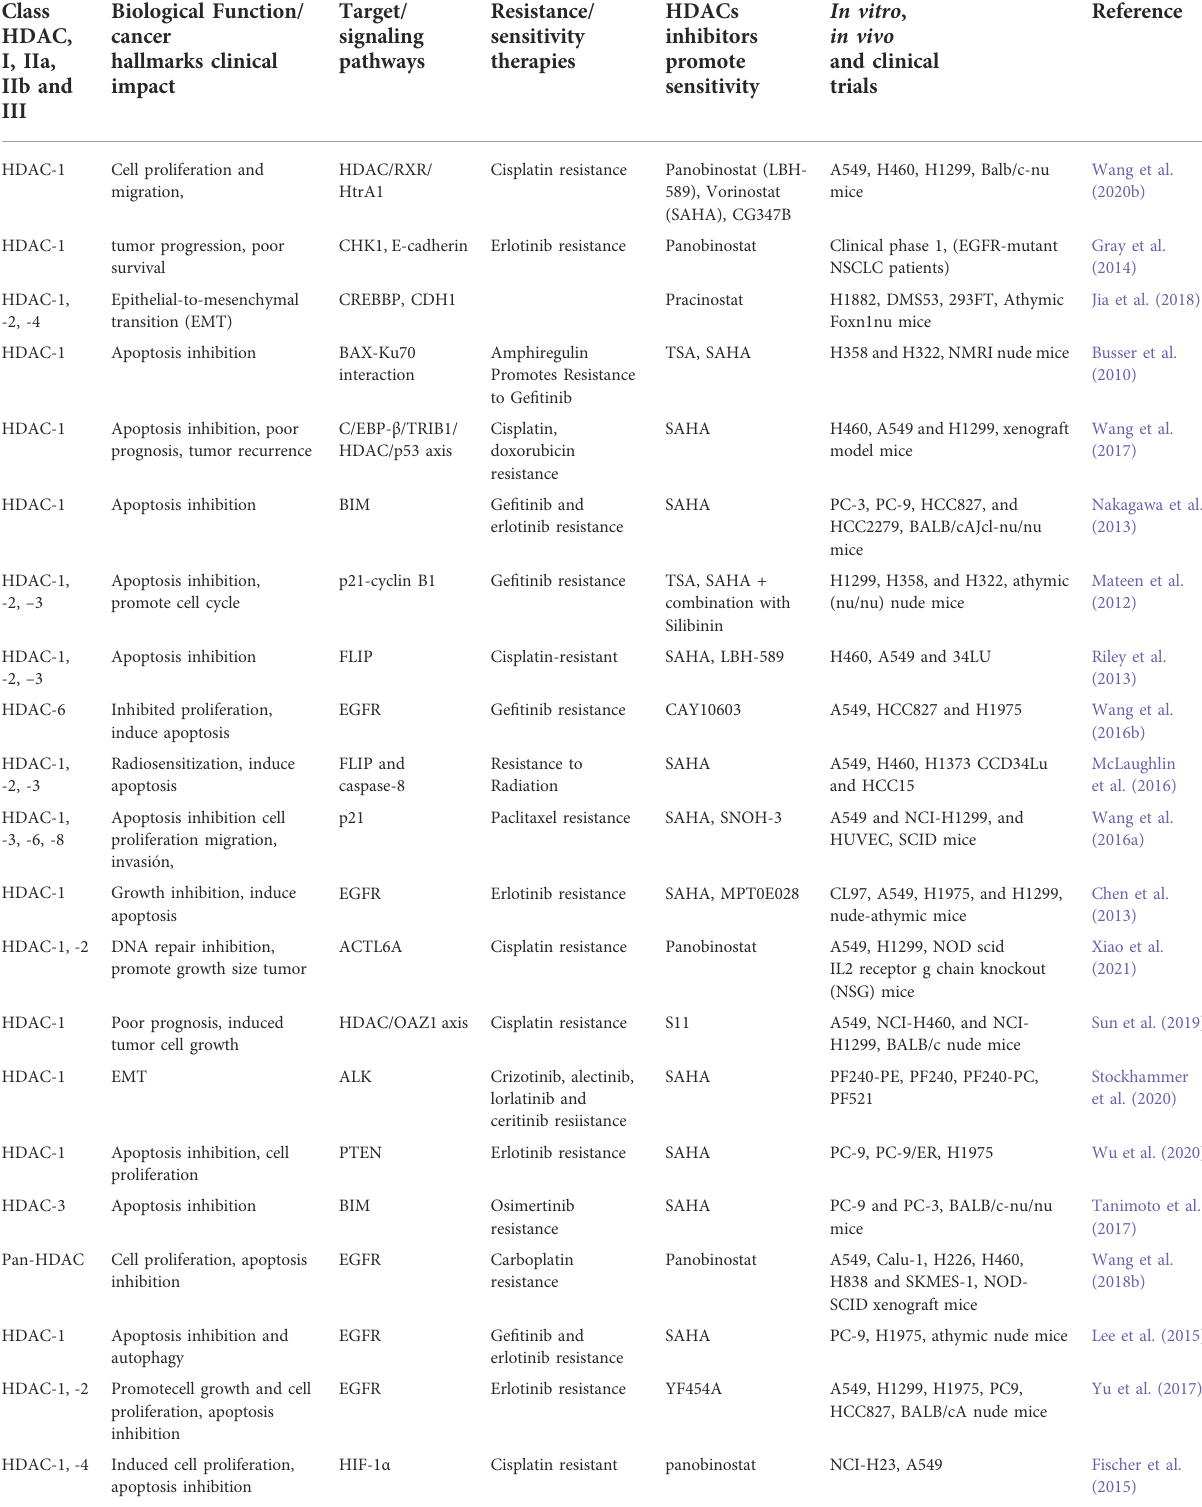
TABLE 1 HDACs regulate the resistance to therapies in lung